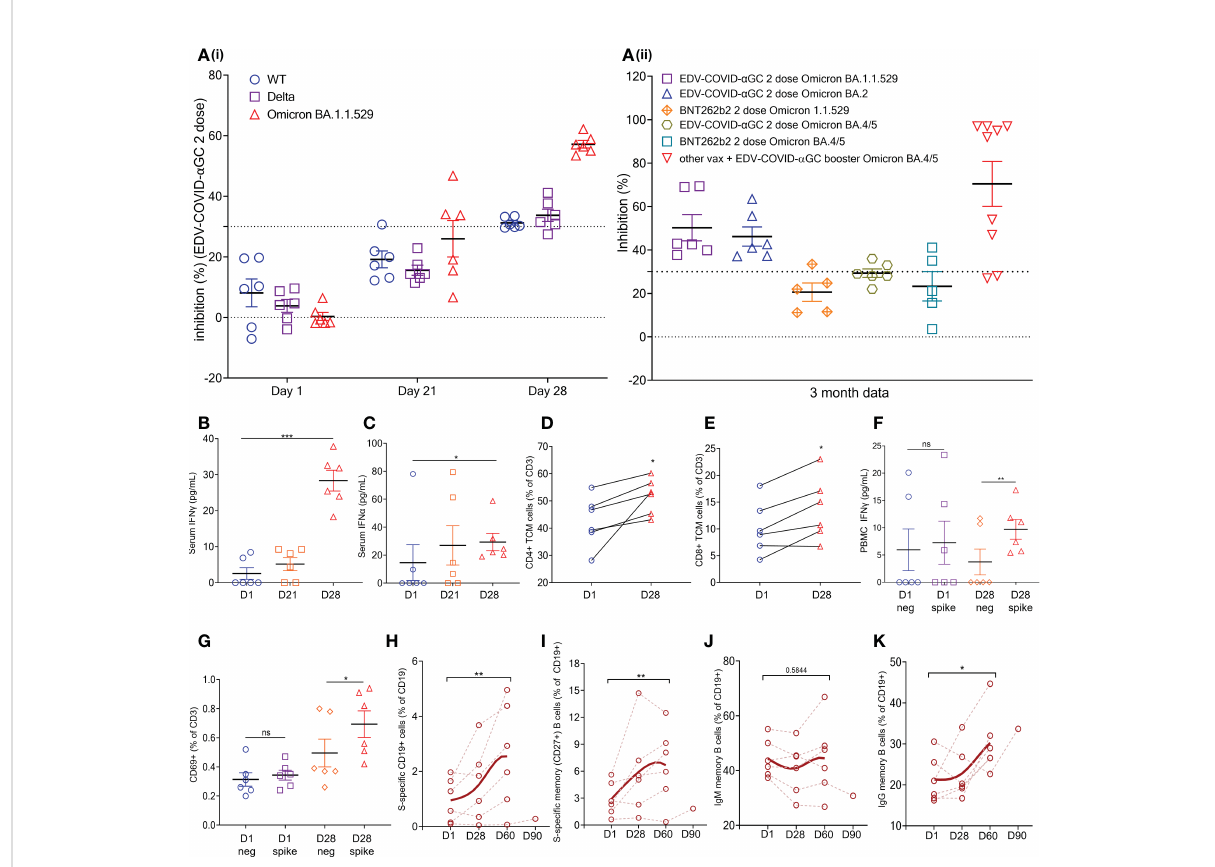
FIGURE 4 EDV-COVID- a GC Clinical trial: Data from the 6 volunteers. (Ai) SVNT analysis of volunteer serum on day 1, 21, 28 post-initial injection and a booster on day 21 against wild type, Delta and Omicron B.1.1.529 variants of the SARS-CoV-2 RBD. (Aii) SVNT analysis of volunteer serum against Omicron B.1.1.529 and Omicron BA. 2 and BA. 4/5 variants of the SARS-CoV-2 RBD, at 3 months post 2 doses of EDV-COVID- a GC only, 2 doses of BNT262b2 only, and EDV-COVID- a GC as a booster. Dotted line represents sVNT 30% cut-off correlating to a positive